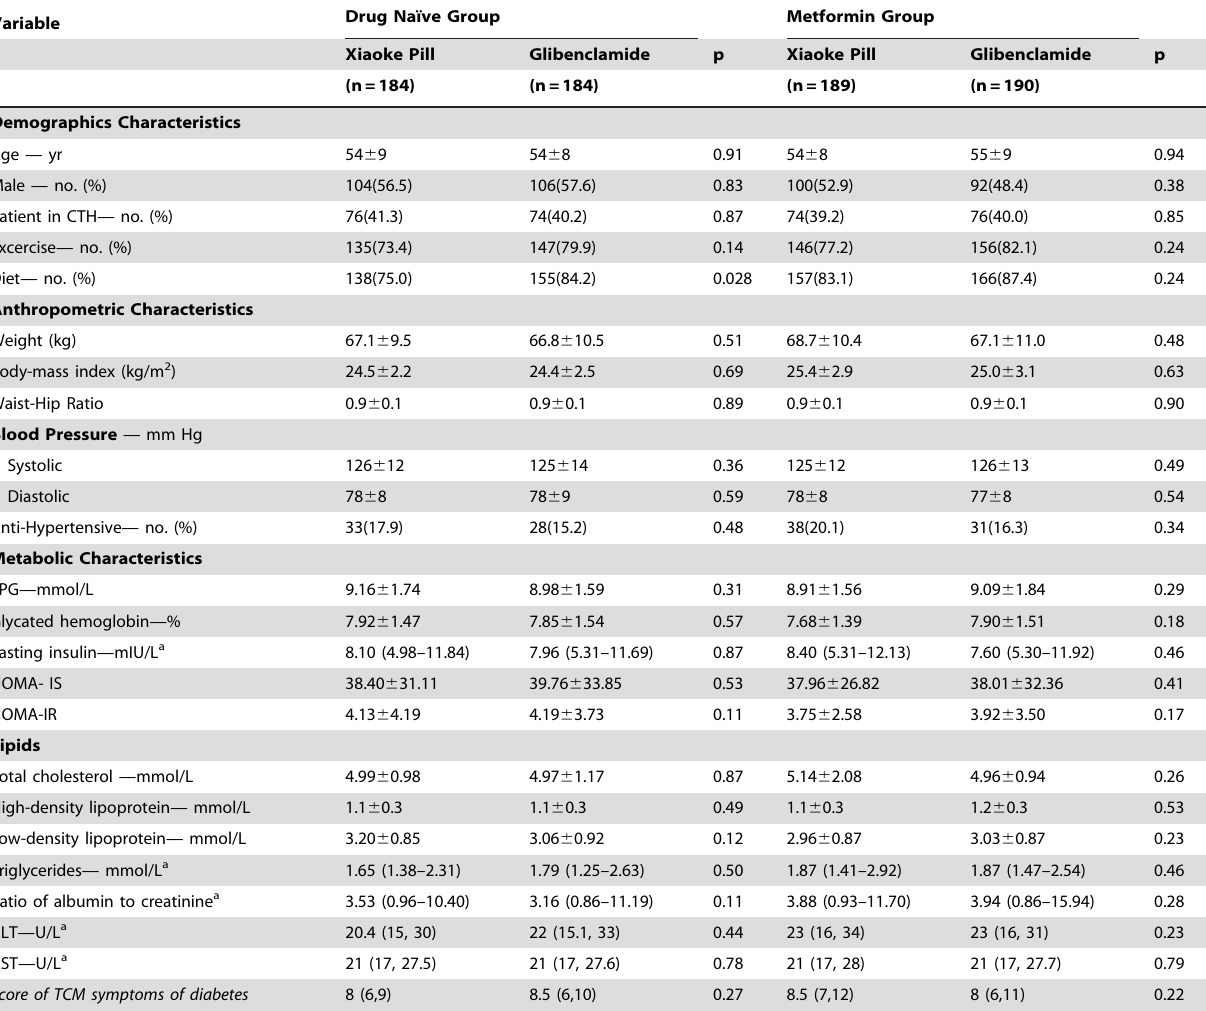
Table 1. Characteristic of the Patients at